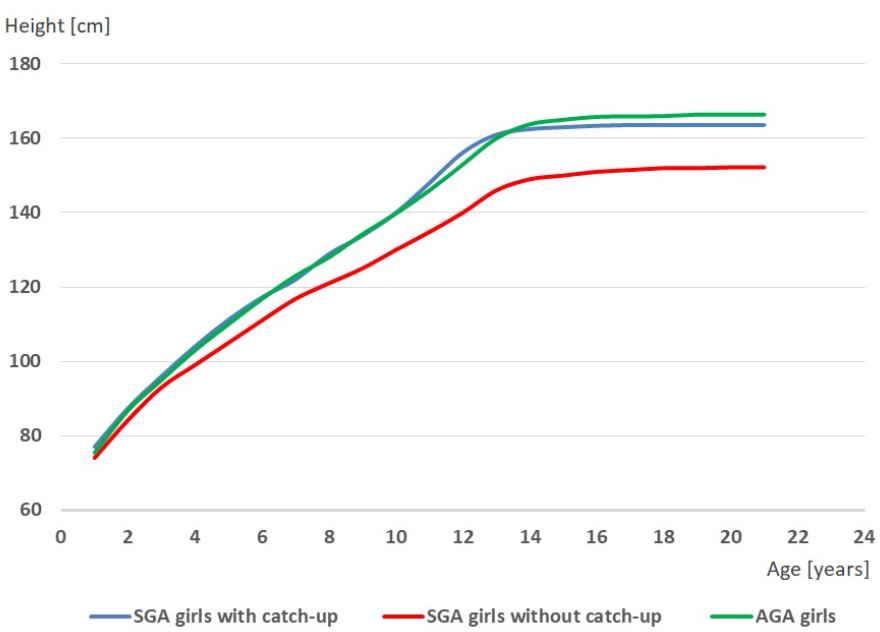
Figure 3. Growth curves of girls born small for gestational age (SGA) with catch-up growth, girls born small for gestational age (SGA) without catch-up growth, and girls born appropriate for gestational age (AGA).